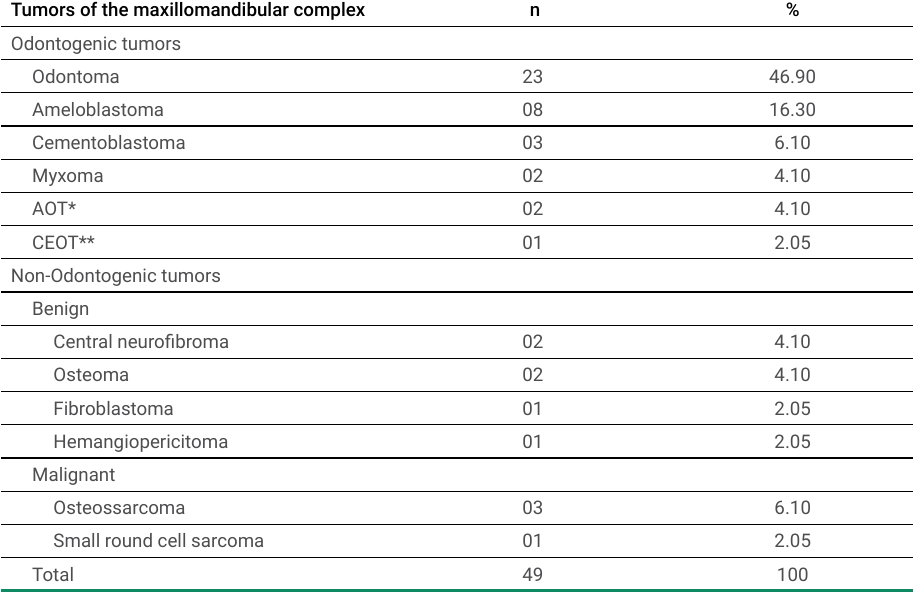
Table 2. Tumors of the maxillomandibular complex according to frequency and percentage, CRLB, UEFS, 2006-2018. Tumors of the maxillomandibular complex